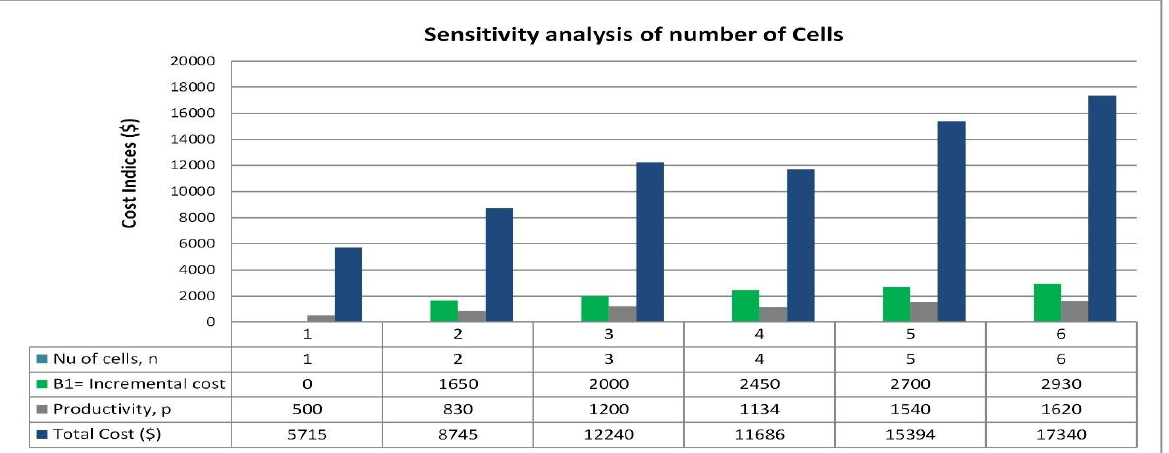
Fig. 6: Sensitivity Analysis for number of FMS Cells